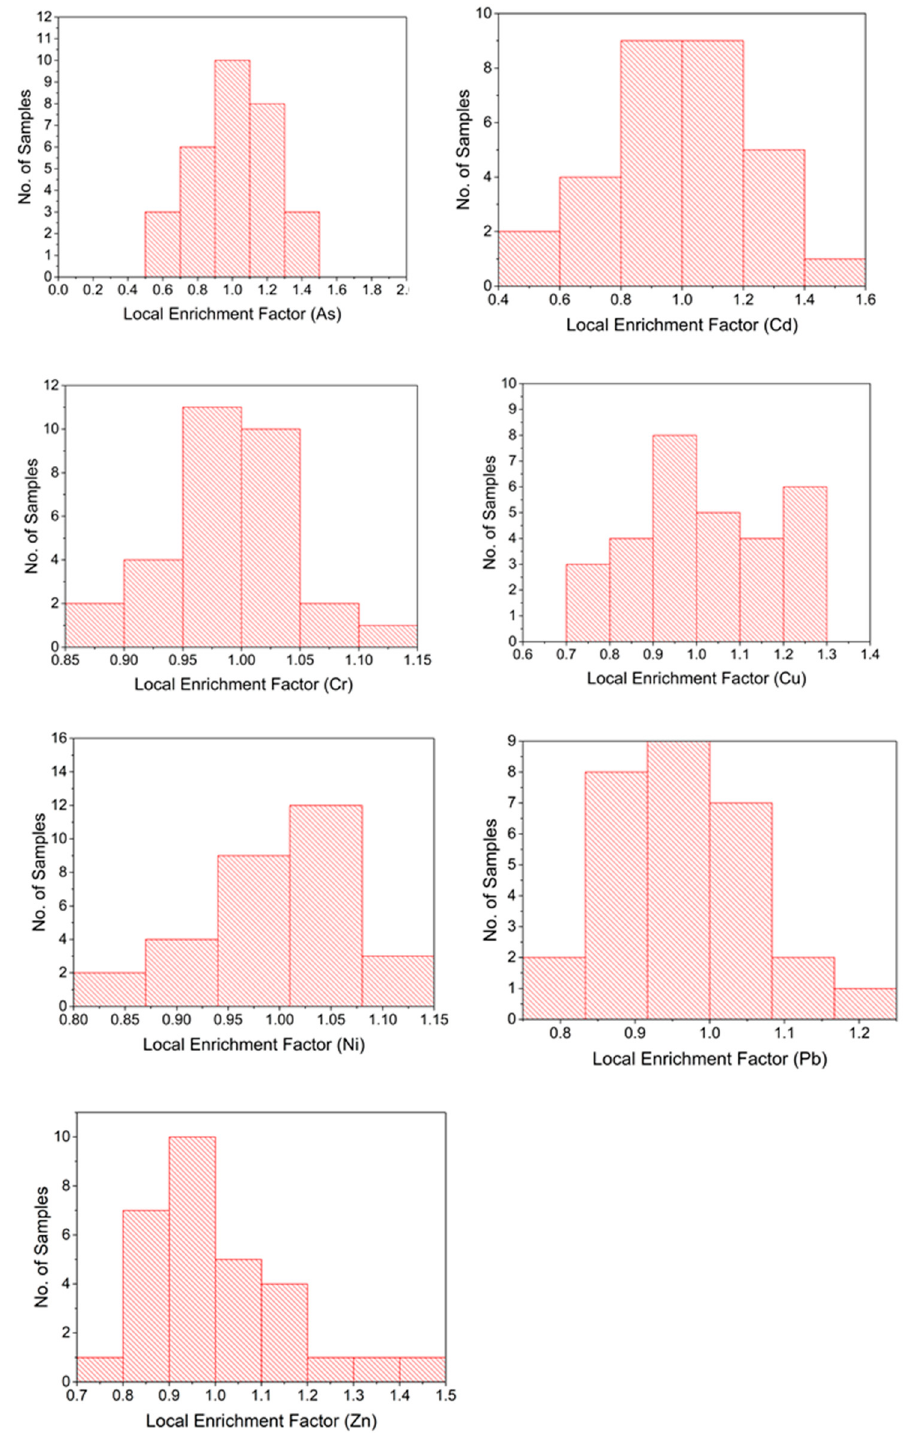
Figure 11. Histograms of local enrichment factors calculated for reach RS. Note that LEFs vary around 1.